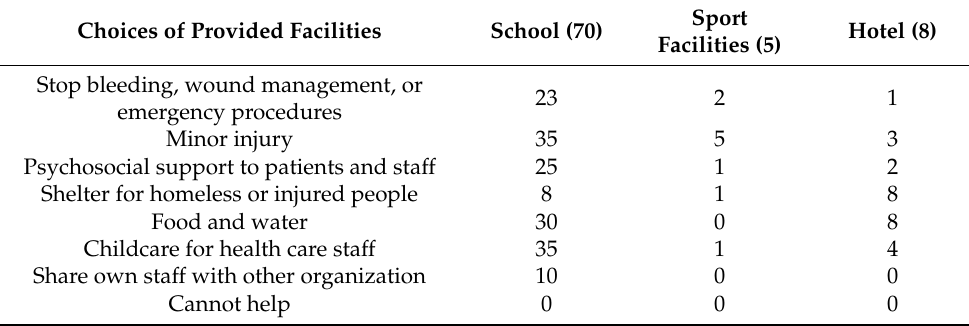
Table 3. Questionnaire data of potential support those facilities could